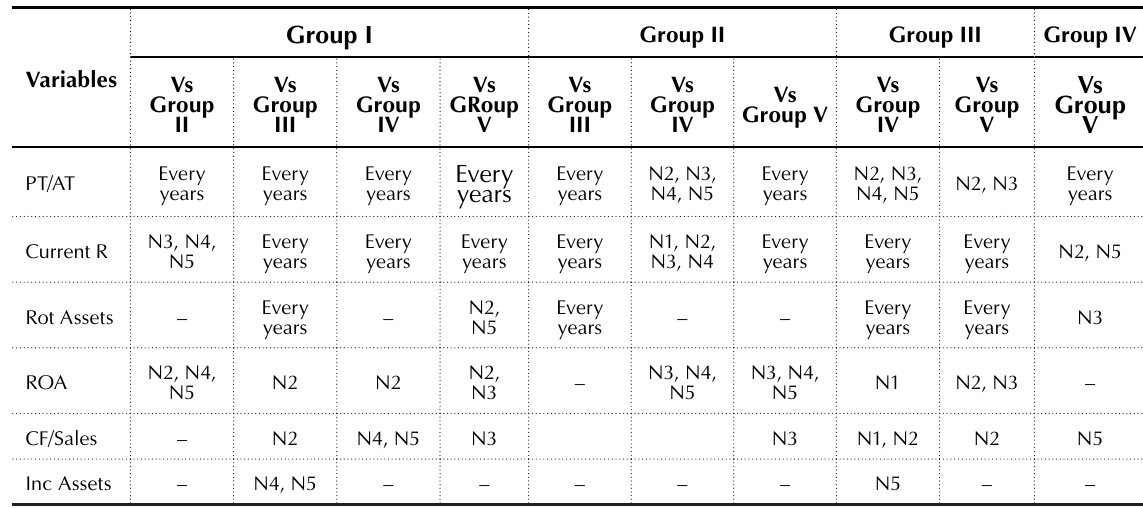
Table 6. Summary contrast independent grouping (K-W)